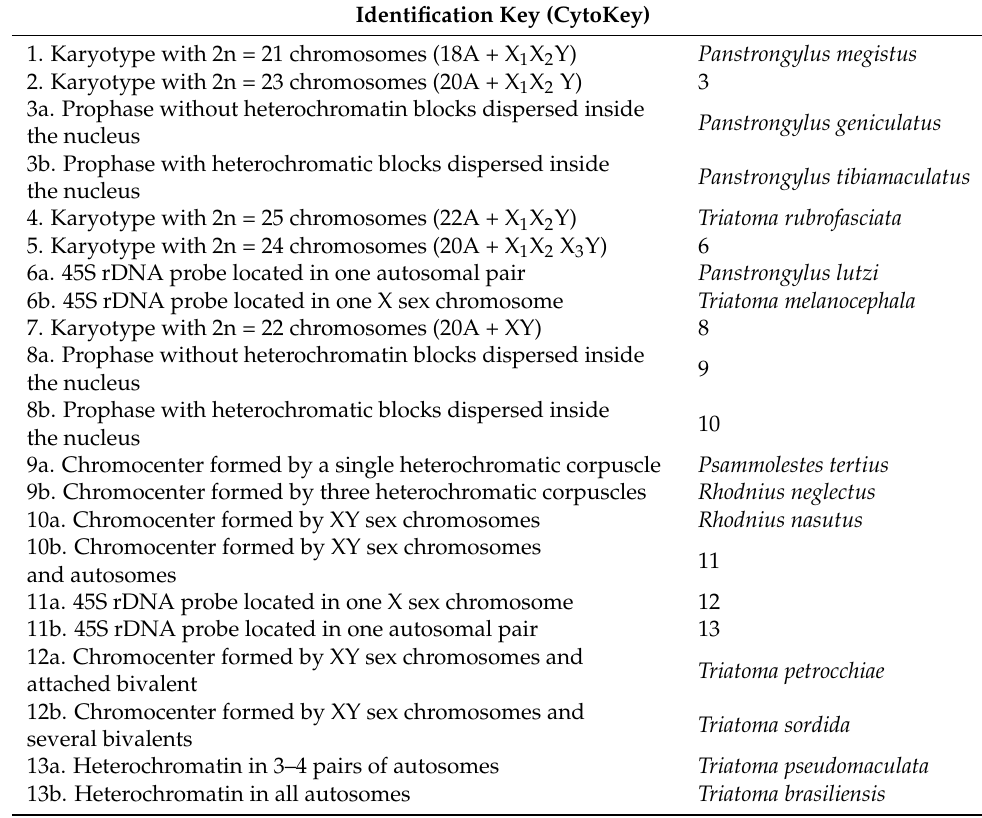
Table 1. Dichotomous key for species from Pernambuco, based on cytogenetic data. Identification Key (CytoKey)